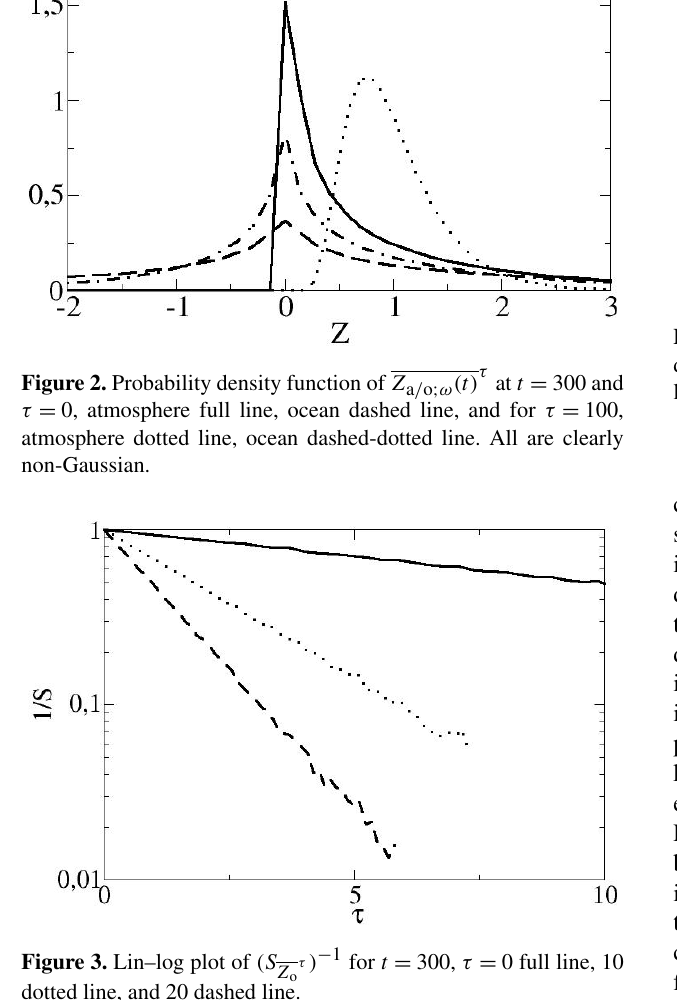
Figure 3. Lin–log plot of (S dotted line, and 20 dashed line.